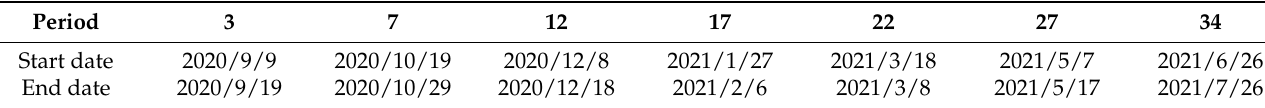
Figure 4. Savitzky–Golay (S-G) filtering effects. Table 1. Dates corresponding to period